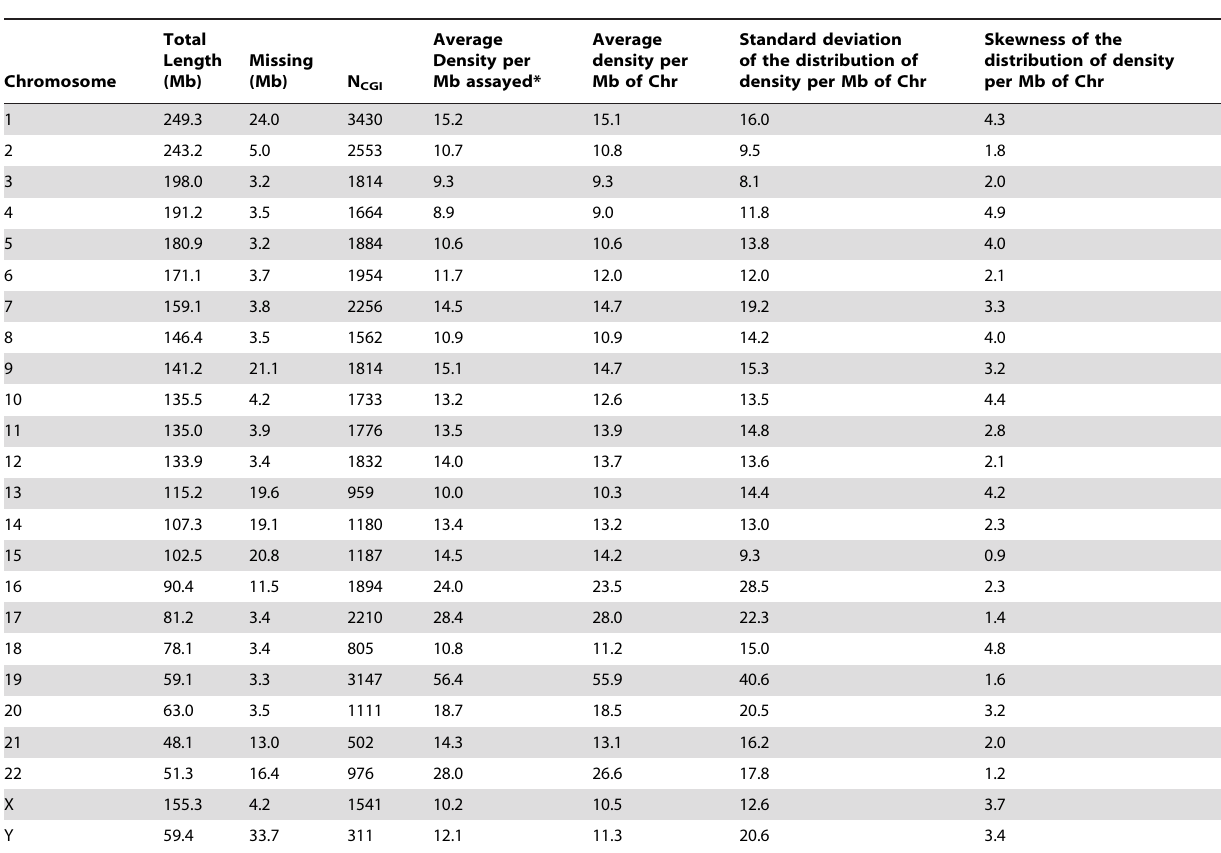
Table 1. Summary statistics for the CGI densities for each